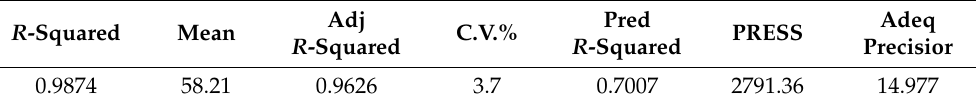
Table 2. Results of error statistical